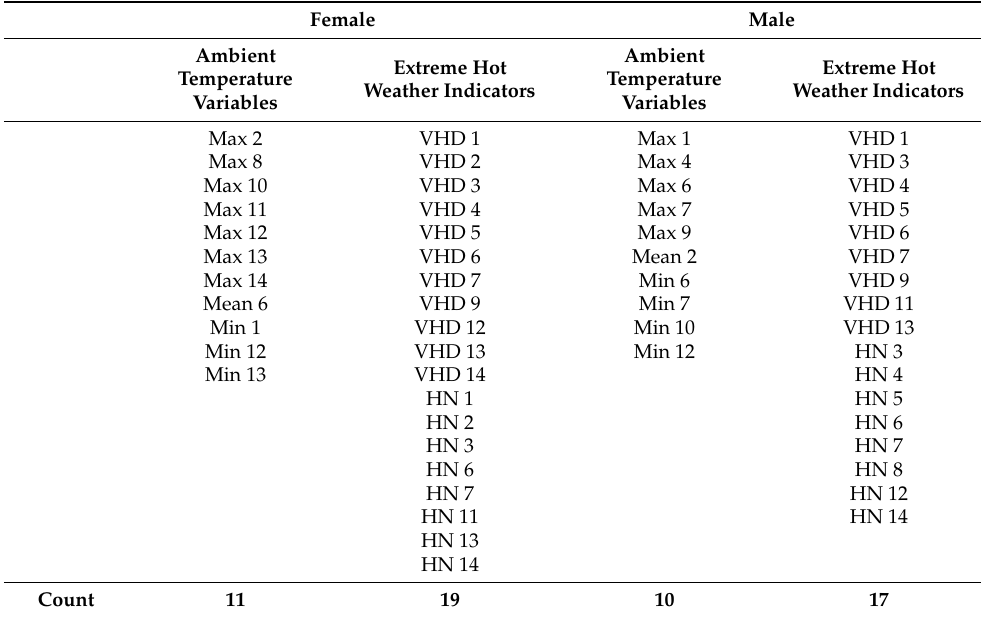
Table 1. LASSO selected ambient temperature variables for each group.